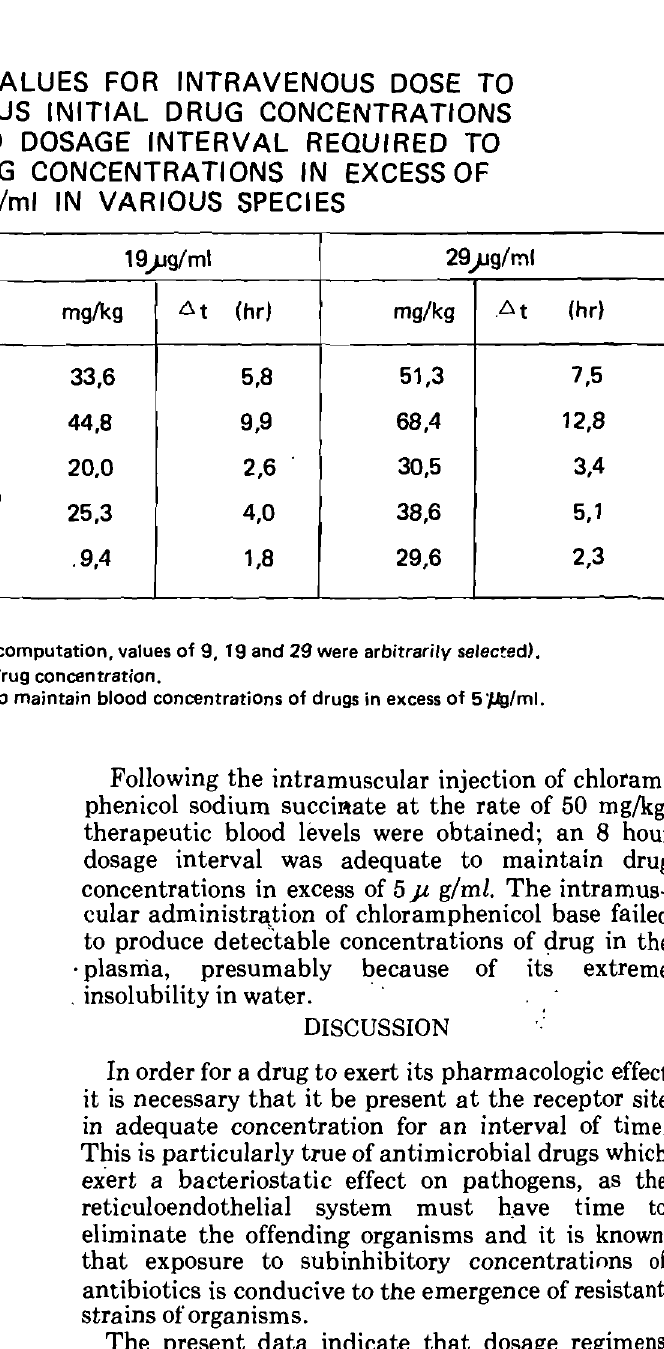
CALCULATED VALUES FOR INTRAVENOUS DOSE TO